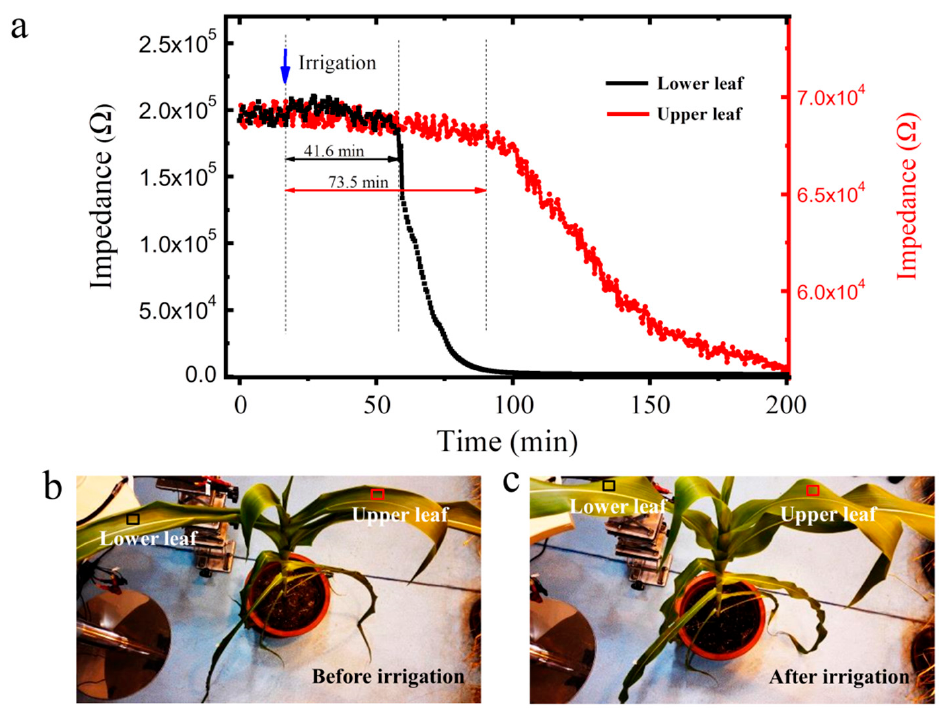
Figure 7. ( a ) Time for water to reach different leaves from the roots after irrigation; ( b ) plant morphology before irrigation; ( c ) plant morphology after irrigation.